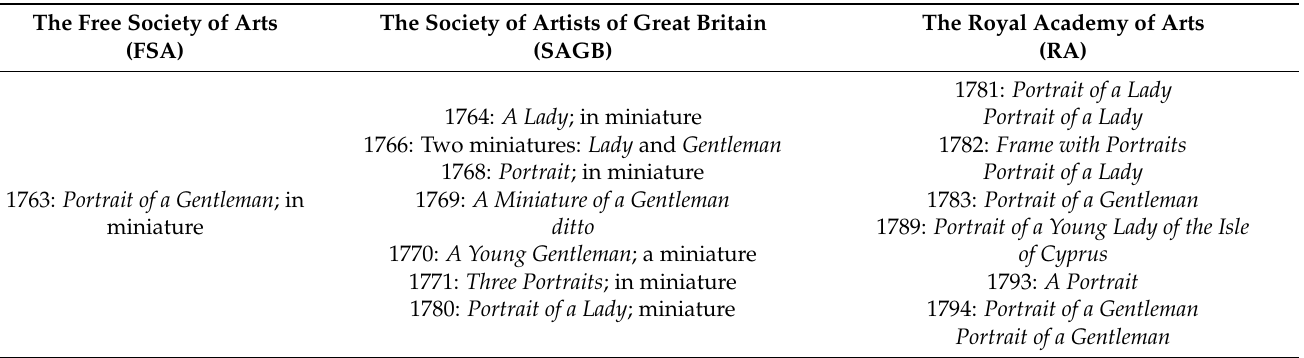
Table 1. William Pether’s miniatures exhibited at the Free Society of Arts, the Society of Artists of Great Britain, and the Royal Academy of